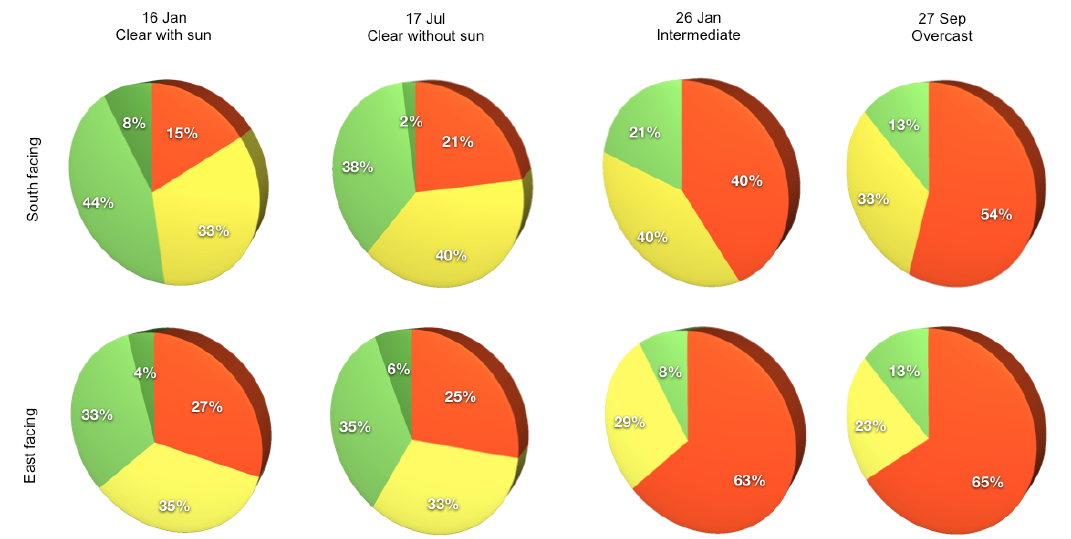
Figure 12. Artificial light requirement for each orientation during typical days. Yearly sky conditions are 71% overcast, 14% intermediate, and 15%